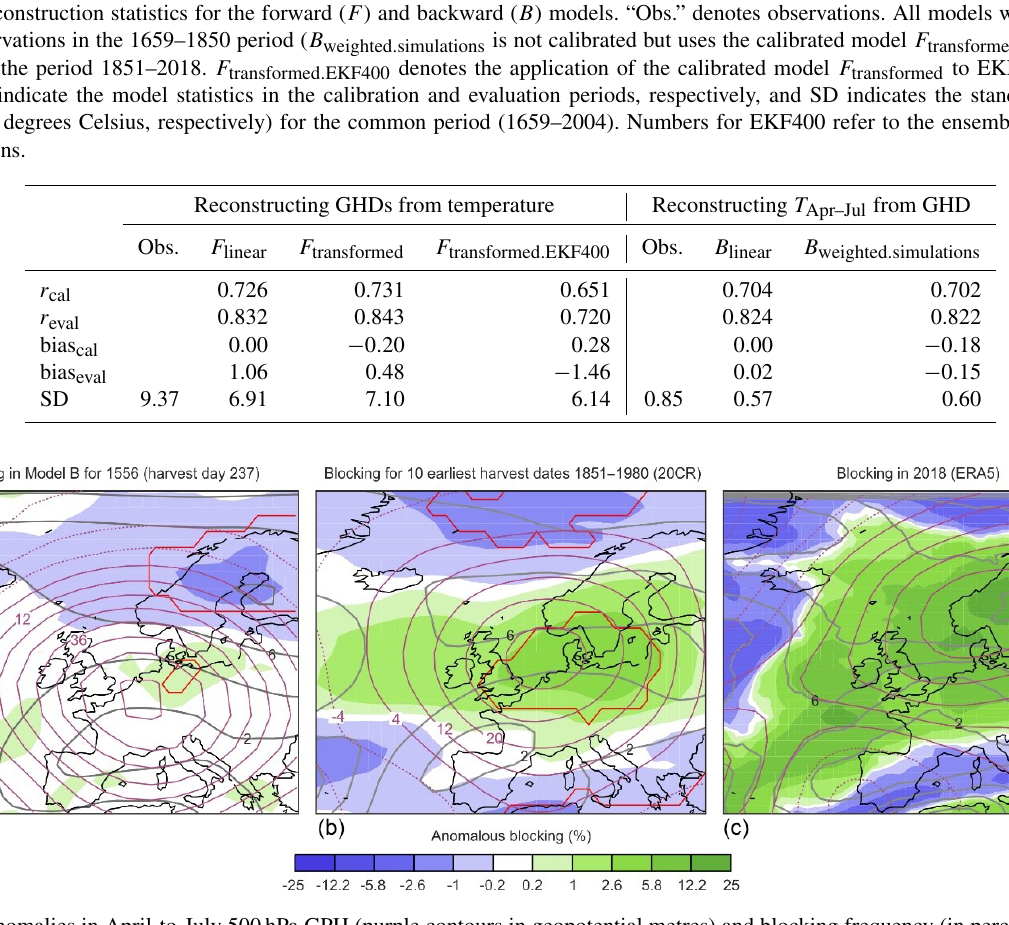
Figure 9. Anomalies in April-to-July 500hPa GPH (purple contours in geopotential metres) and blocking frequency (in percentage of time steps blocked, note the non-linear scale) in (a) model B weighted . simulations for 1556 (relative to all years prior to 1850) as well as (b) averaged for the 10 earliest harvest dates in 1851 to 1980 in 20CRv2c (relative to 1851–1980). Panel (c) shows anomalous 500hPa GPH and blocking in April to July 2018 in ERA5 (relative to 2000–2018). Grey solid contours give the corresponding blocking climatologies (in percentage of time steps blocked). Red lines indicate where the 5% to 95% confidence interval for anomalous blocking is exceeded based on 1000 repetitions of a Monte Carlo sampling of the weights (for model B ) or years in 20CRv2c,